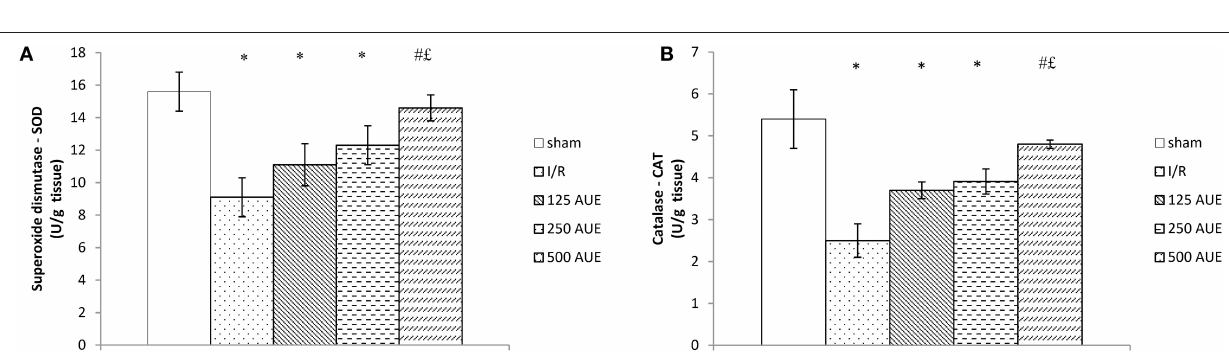
FIGURE 4 | Effects of consumption of increasing doses of AUE on the value of superoxide dismutase (SOD) (A) , catalase (CAT) (B) , and reduced glutathione (GSH) (C) (n = 50, 10 animals per group). Values are shown as mean ± SE. *Statistically significant difference at the level of p < 0.05 in relation to the I/R group; £ Statistically significant difference at the level of p < 0.05 compared to sham. n = 10 animals per group.